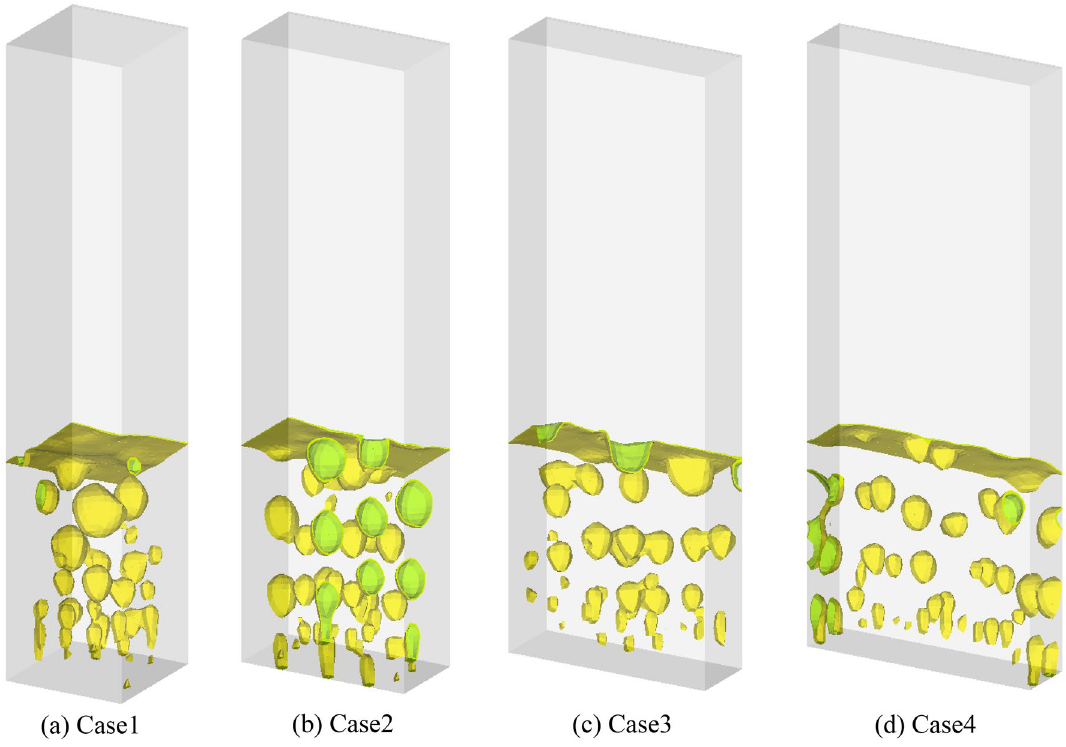
Figure 6. Bubbles for different shapes of fluidized bed column.